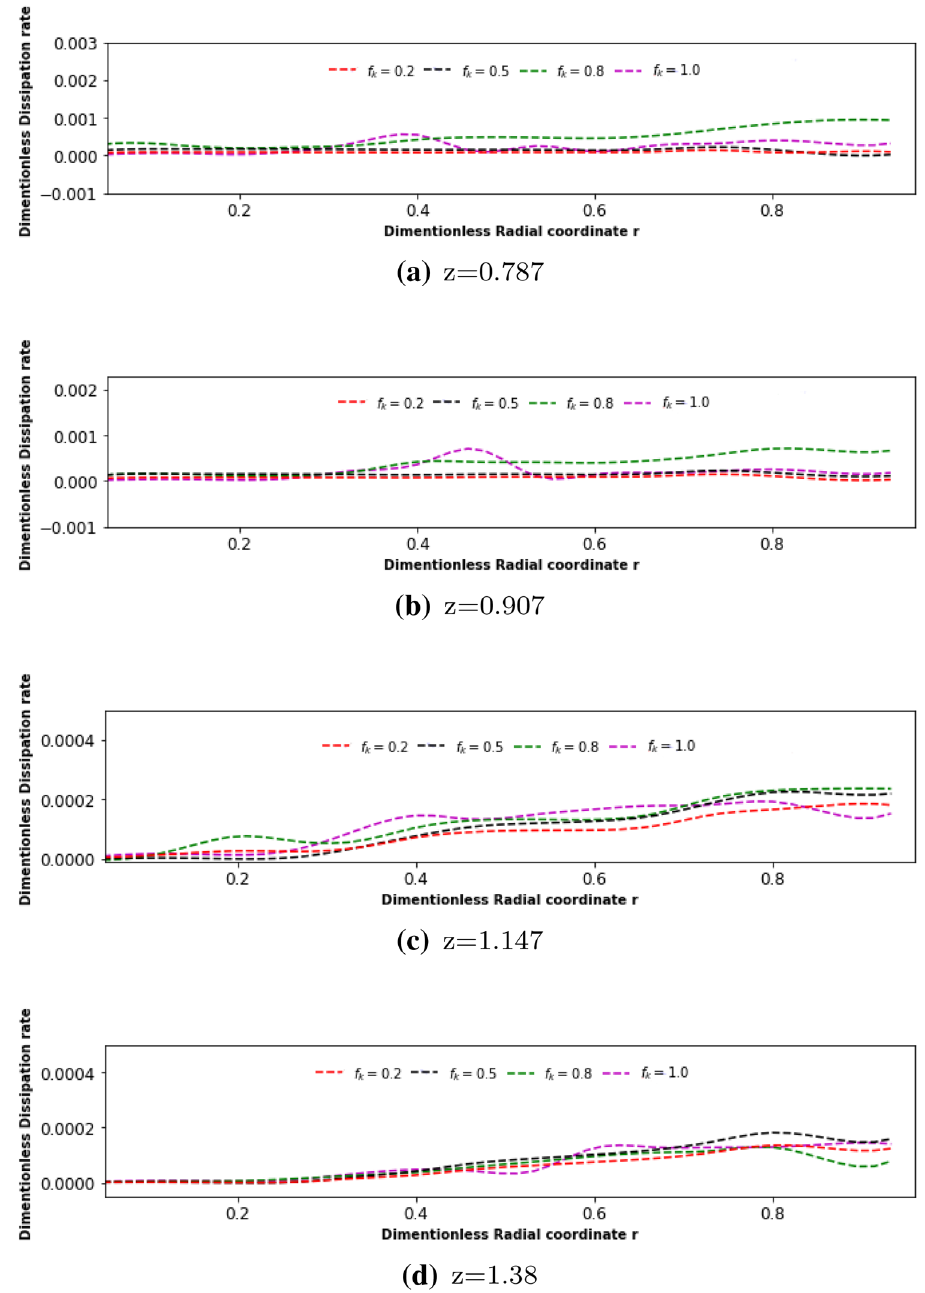
Fig. 13 Profiles for turbulent energy dissipation rate above the impeller at different z-location for f k = 0.2 ( - - - ), = 0.5 ( - - - ), f = 0.8 ( - - - ), f k k